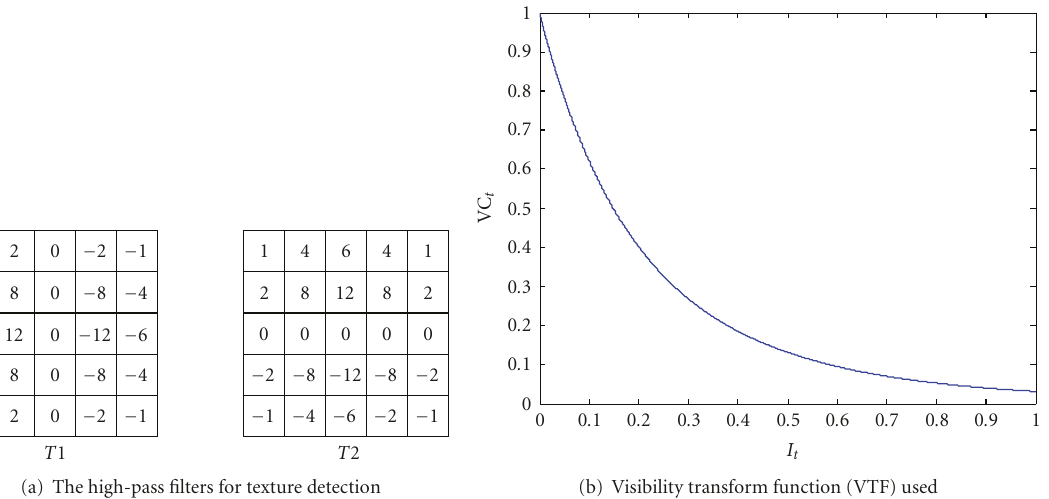
Figure 6: Implementation of the texture masking.